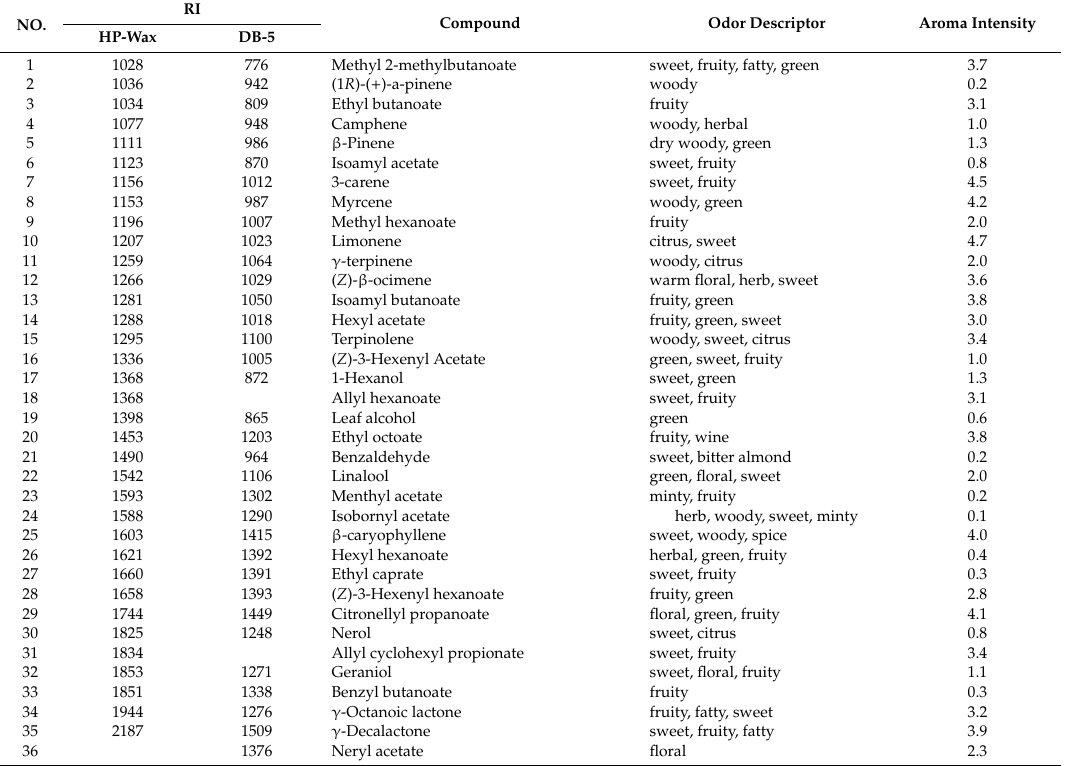
Table 1. Aroma compounds identified by GC-O in mango and vodka